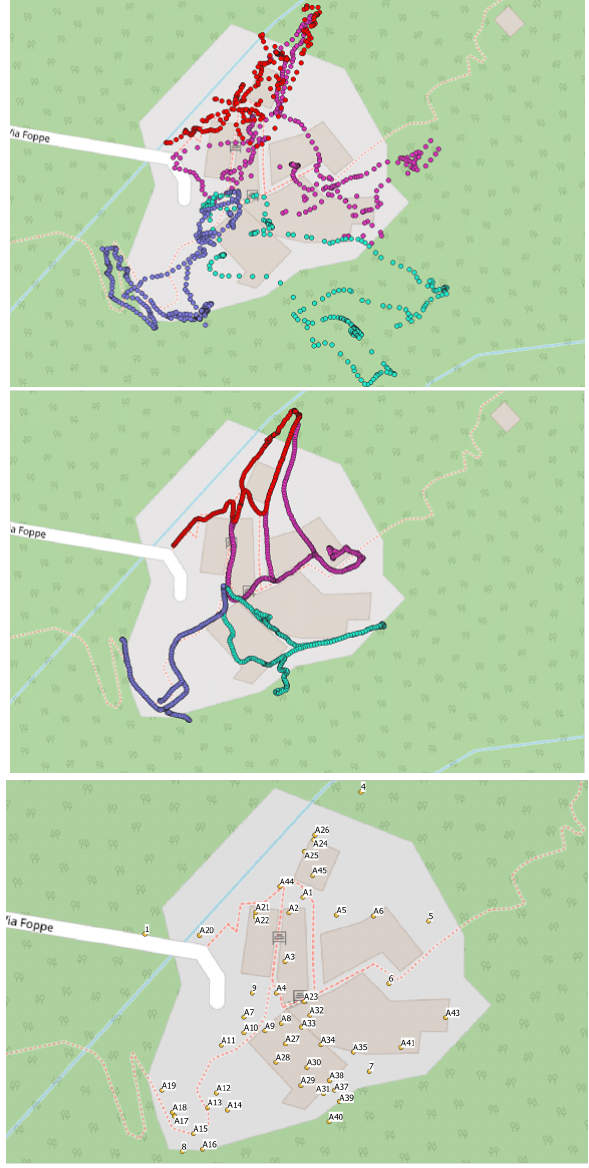
Figure 10: Trajectory provided by mobile phone (top) and after bundle adjustment (centre) and GCPs/CPs position (bottom).